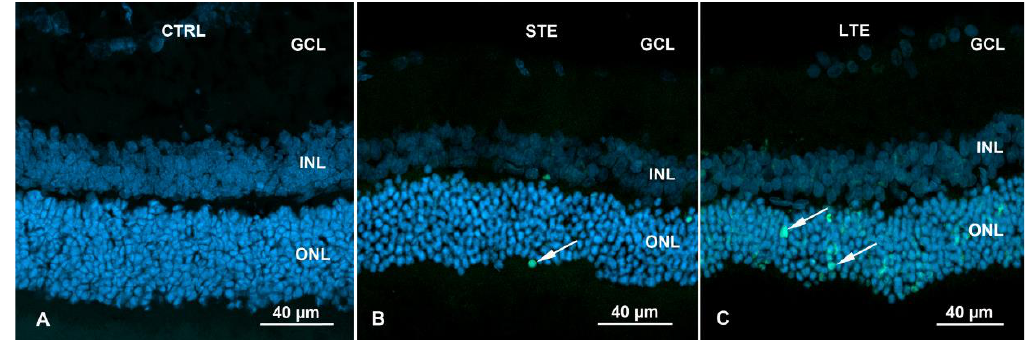
Figure 8. TUNEL assay of Wistar rat retinas. Blue fluorescence shows nuclei stained with DAPI. The rats were exposed to 12 h white light (150 lx) and 12 h darkness for 10 d (control, CTRL; 9 rats), cycles of 12 h blue light (150 lx) and 12 h darkness for 10 d (long-term exposure, LTE; 9 rats), and constant blue light (150 lx) for 2 d (short-term exposure, STE; 9 rats). ( A ) Retina from a rat in the control group. Note: no labelling for apoptosis. ( B ) Retina from a rat in the STE group. Isolated nuclei display labelling for apoptosis (white arrows, green fluorescence) in the ONL. ( C ) Retina from a rat in the LTE group. Note: more labelling for apoptosis is present in the ONL (white arrows, green fluorescence). Samples were visualized and photographed with a confocal microscope (LSM900, Zeiss). Abbreviations: ONL, outer nuclear layer; INL, inner nuclear layer; GCL, ganglion cell layer.